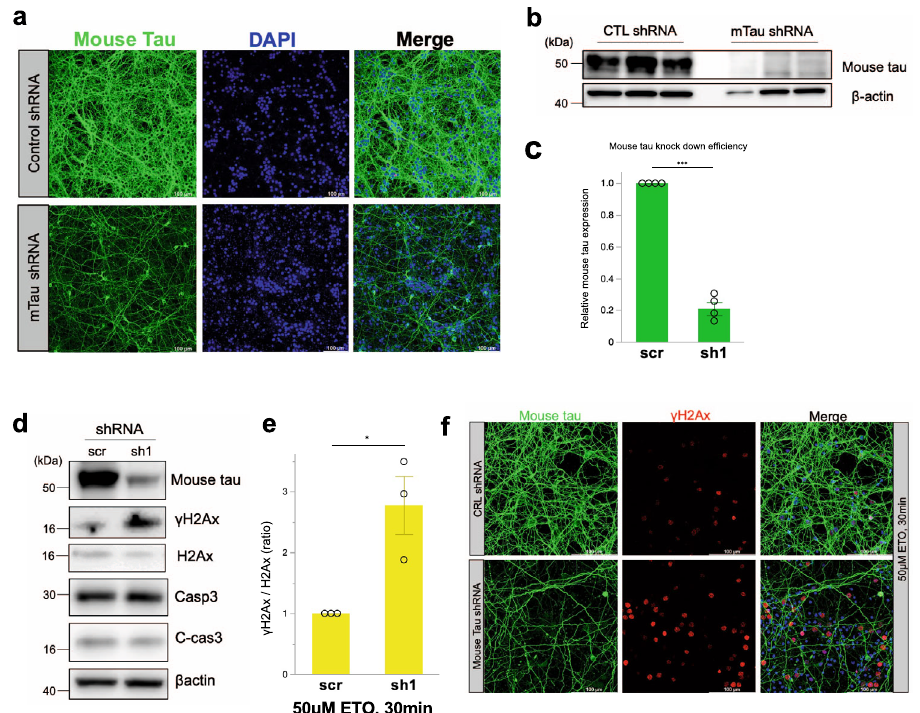
Fig. 6 Mouse tau shRNA lentivirus knockdown exacerbates DSB. a Confocal microscopy images of mouse tau (green) and DAPI (blue) on primary mouse cortical neurons. Primary mouse cortical neuron cultures (DIV 0) were transduced by mouse tau and control shRNA lentivirus particles, cultured for 7 days. Scale bar = 100 μ m. b Endogenous mouse tau expression with anti-mouse tau antibody for control (CTL) and mouse tau (mTau) shRNA knockdown ( n = 3). c Quantitation of mouse tau expression, scr: control shRNA, sh1: mouse tau shRNA colne 1, n = 4, n: number of samples for WB, ***